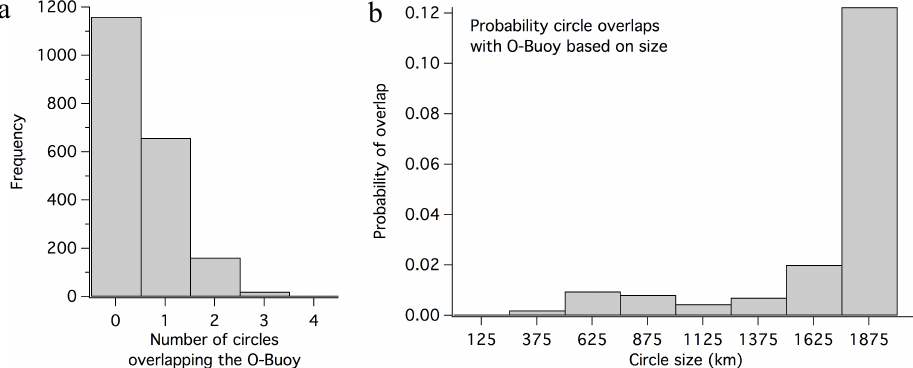
Figure 9. Results from Monte Carlo simulation experiment. (a) Based on the size distribution as defined by the ODE definition (O 3 ≤ 15pmolmol − 1 ), circular areas were shown to not overlap with the site of the O-Buoy 58% of the time (mode=0), followed by an overlap of one circle 33% of the time. (b) Plot of the probability that an individual circle overlaps with the measurement site vs. the size of the circle.